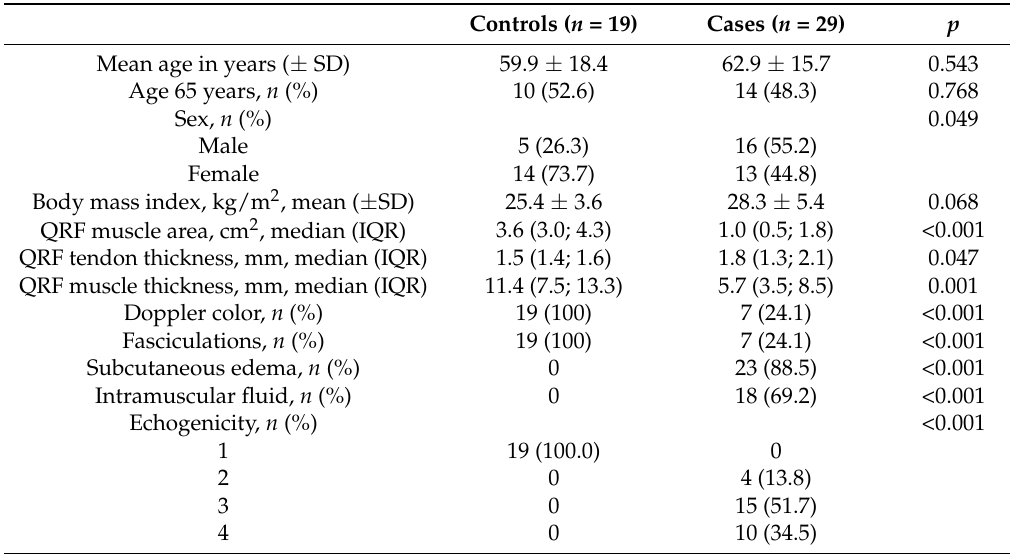
Table 1. Characteristics of the cases and